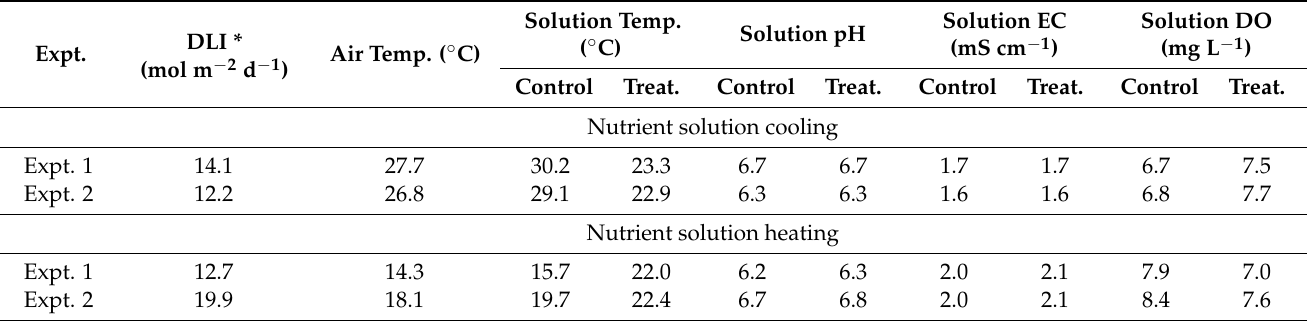
Table 1. Greenhouse environmental conditions and solution characteristics during two experiments for both cooling and heating studies conducted in 2020 and